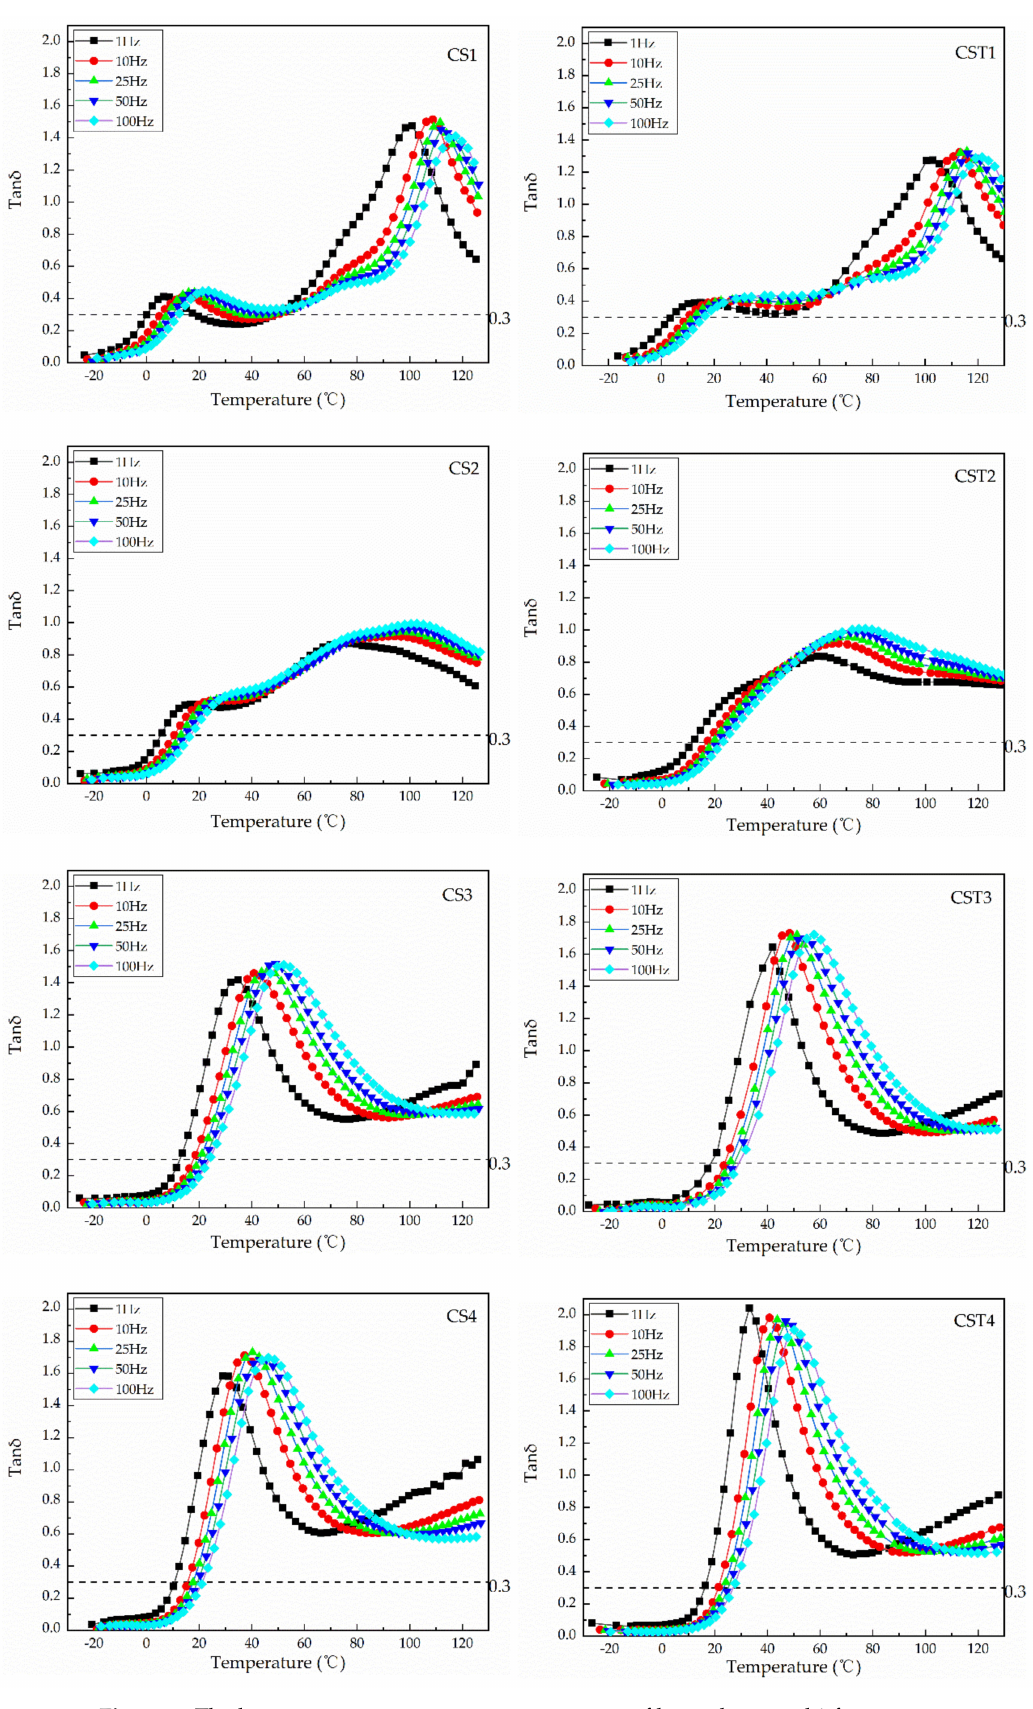
Figure 5. The loss tangent versus temperature curves of latex about